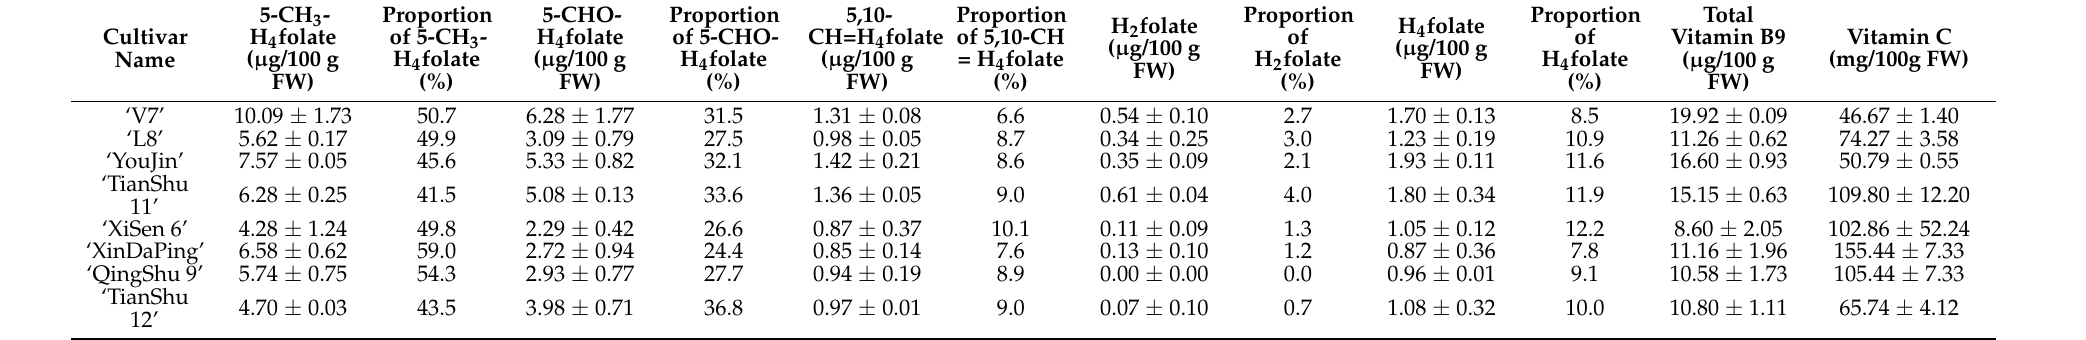
Table 3. The content of water-soluble vitamins among raw tubers of potato cultivars on a fresh-weight basis.